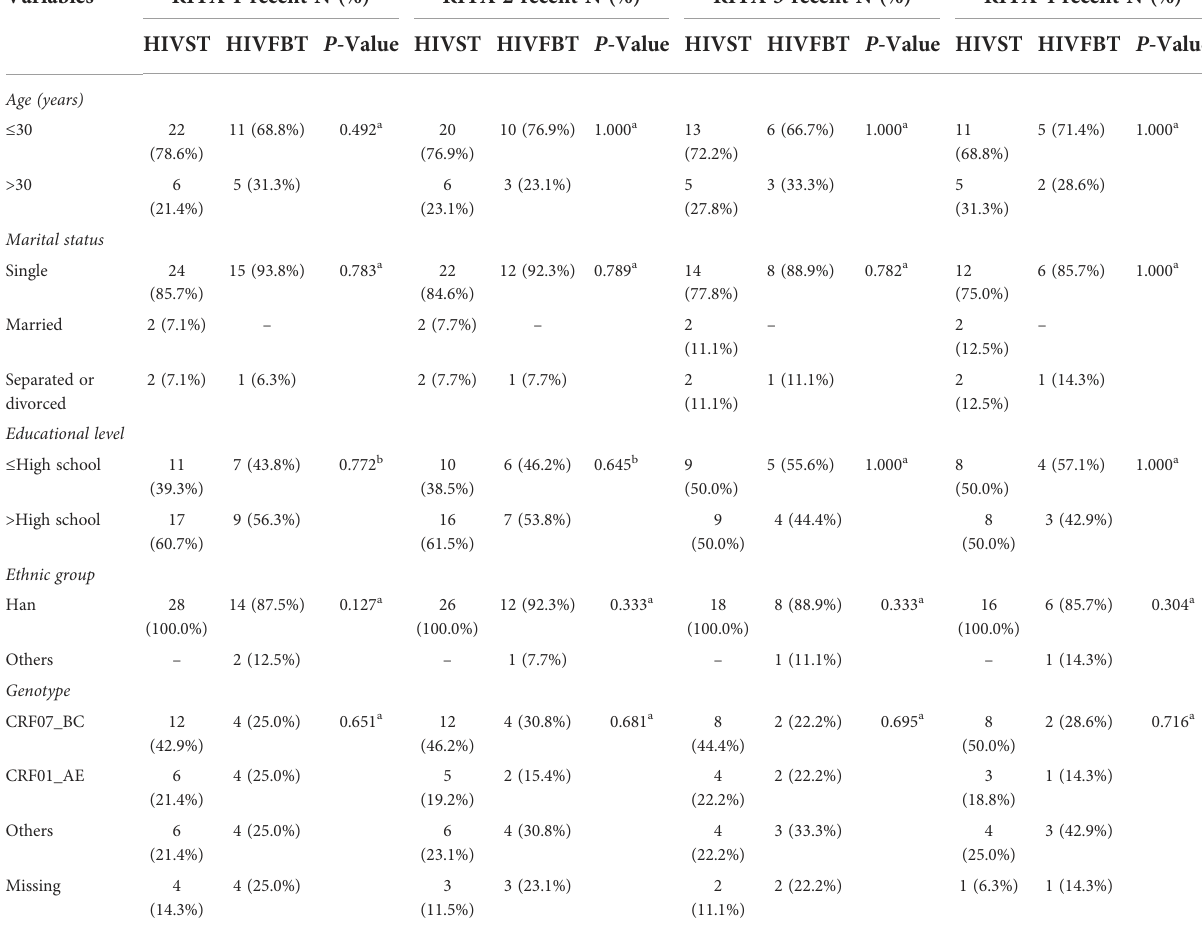
TABLE 3 Sociodemographic characteristics among MSM diagnosed as HIV positive with recency testing results using different recent infection testing algorithms (RITAs) in Zhuhai,